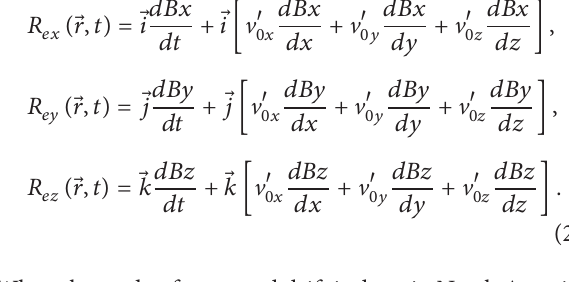
Europe for the time between 1991 and 2006. Equations (20)- (21) are also written in the coordinate system NED. The coordinate system NED ( x -north, y -east, z -down) is used in observatories of http://intermagnet.org/. The velocity of the westward drift is defined for the coordinate system Earth- Centered Earth-Fixed (ECEF). The ECEF or conventional terrestrial coordinate system rotates together with the Earth and has its origin at the center of the Earth. The x -axis passes through the equator at the prime meridian. The z -axis passes through the North Pole. The y -axis can be determined by the right-hand rule to be passing through the equator at 90 degrees of